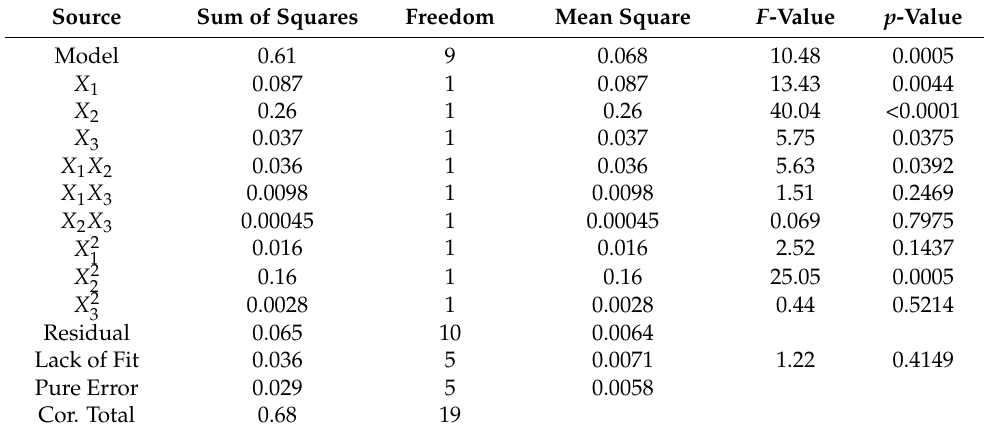
Table 6. Variance analysis results for Y 1 .